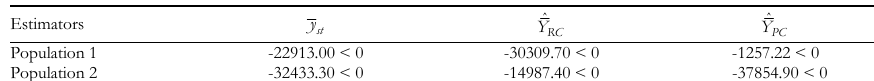
ˆ ˆ y , Y and Y st RC PC